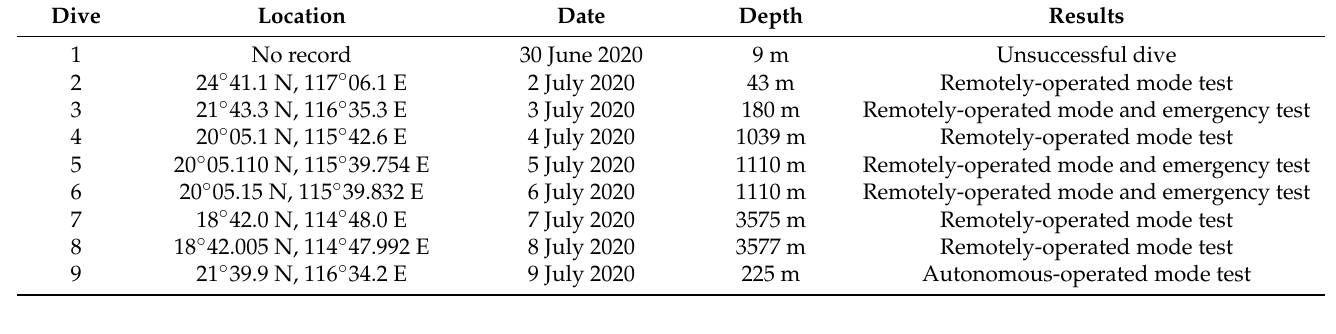
Figure 22. A picture of the ship Xiangyanghong No. 10.